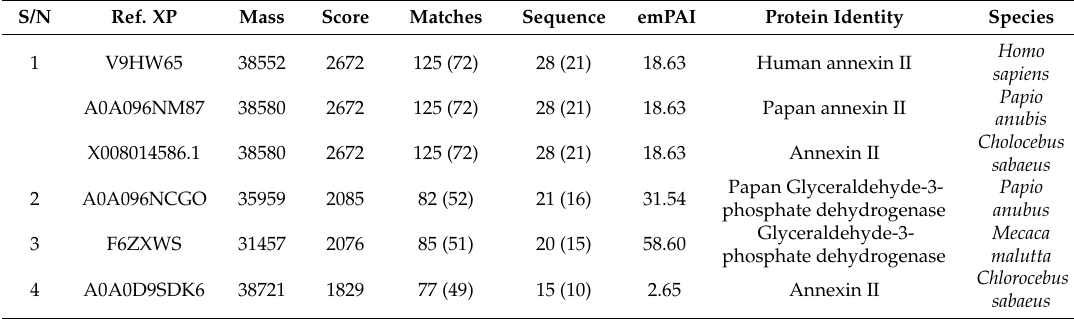
Table 1. Summary of Mascot searches results from peaks generated in MS/MS analysis.